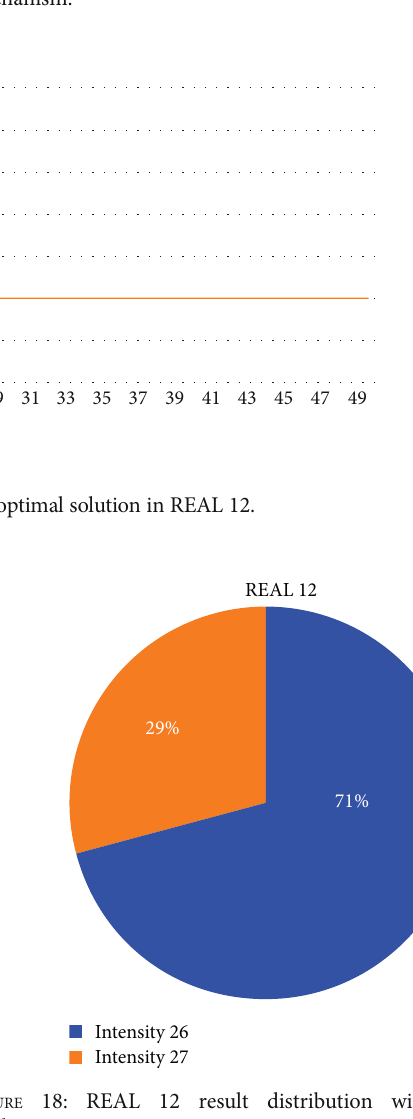
F IGURE 14: REAL 10 result distribution without local search mechanism.